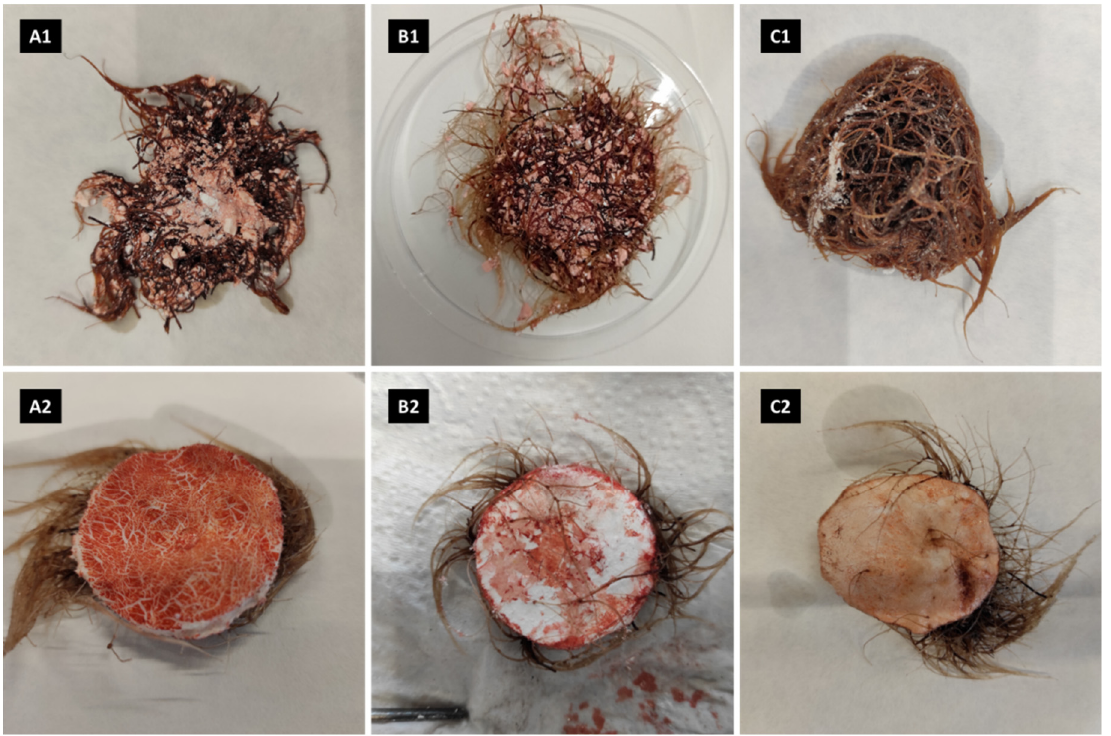
Figure 5. Morphology of R. graeca hairy roots in vitro cultured for 28 days with investigated MTMS- based materials: disintegrated mesoporous xerogel ( A1 ), disintegrated macroporous xerogel ( B1 ), an aggregated precipitate of MTMS ( C1 ), PP-reinforced mesoporous xerogel ( A2 ), PP-reinforced microporous xerogel ( B2 ), PP fibers with a deposited precipitate of MTMS ( C2 ).